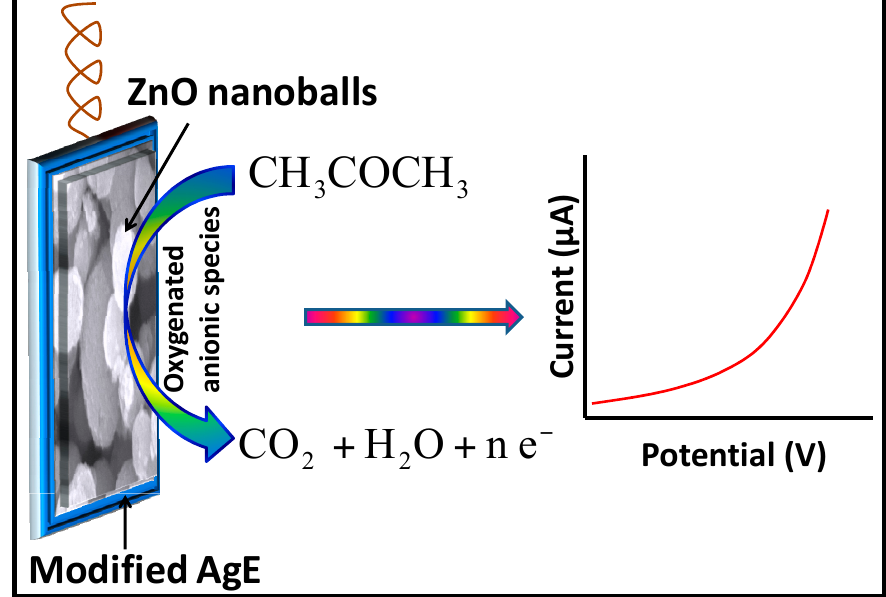
Figure 7. Proposed sensing mechanism for ZnO nanoballs modified AgE towards acetone in PBS.